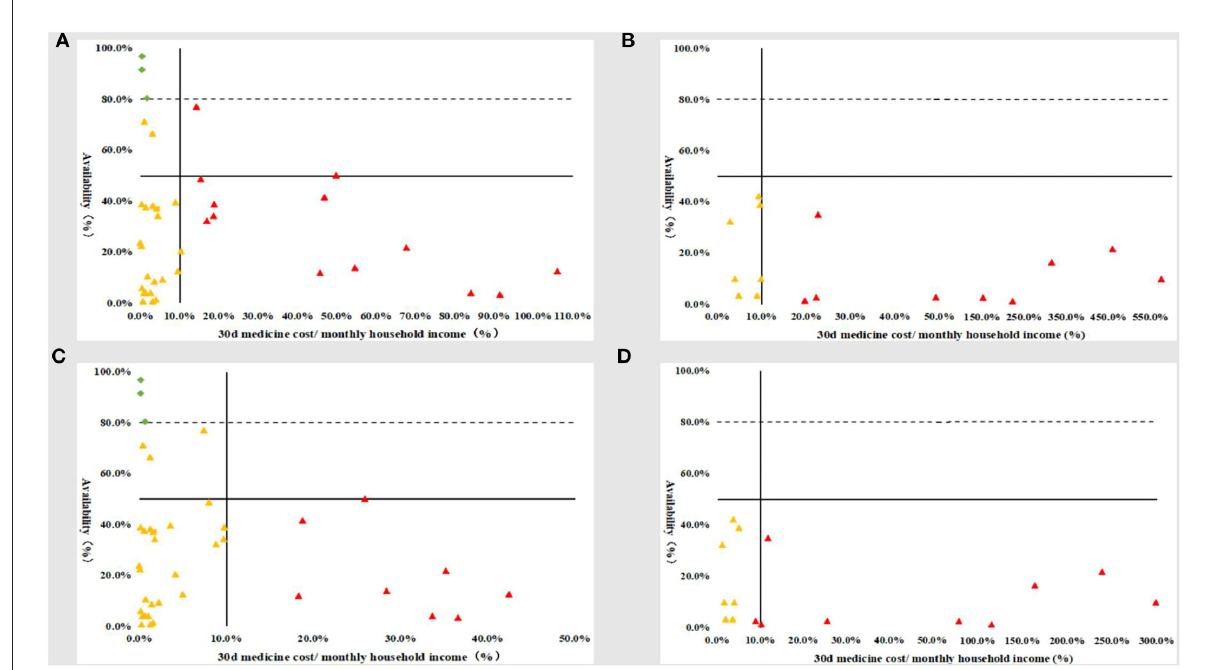
FIGURE2 Comprehensive comparison of the availability and affordability of children’s essential anticancer medicines in the public hospitals in Sichuan Province. (A) Before medical insurance reimbursement_generics; (B) before medical insurance reimbursement_original brands; (C)